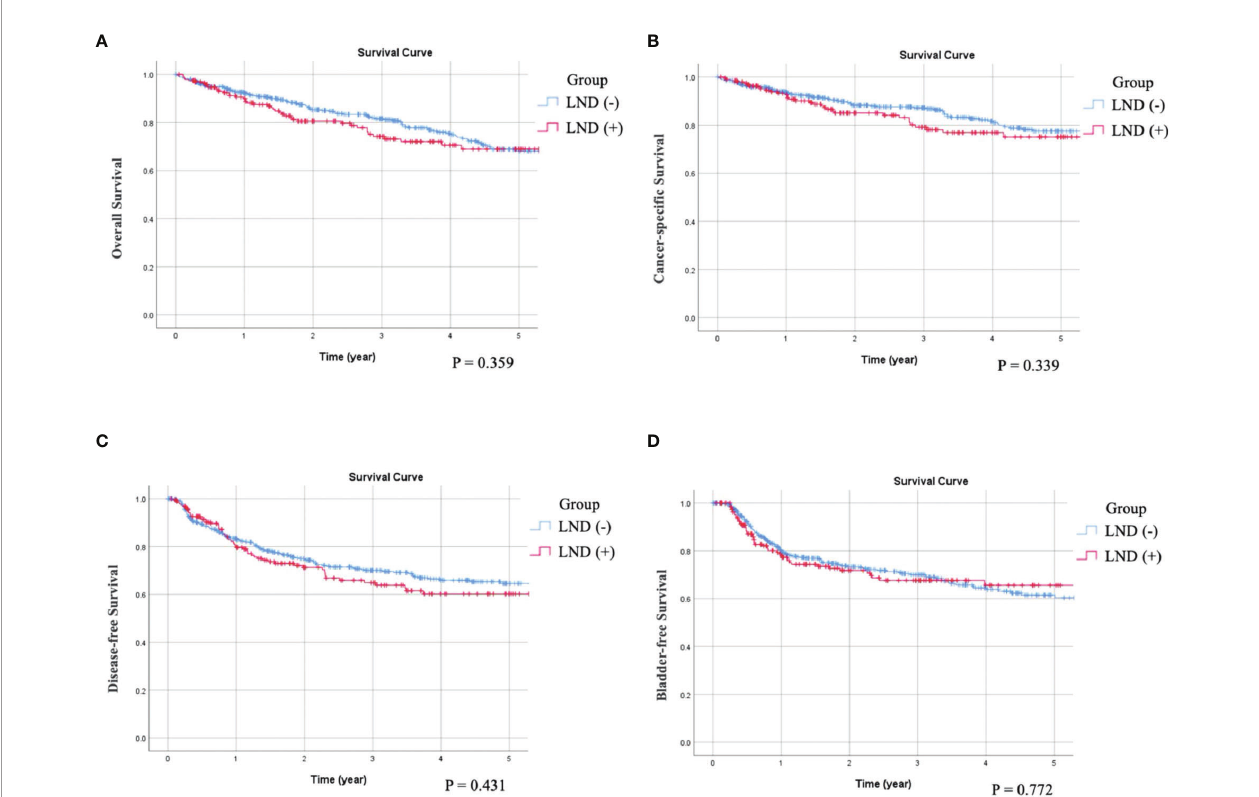
FIGURE 1 | Compare Kaplan-Meier curves between patients without receiving LND (LND (-)) or with receiving LND (LND (+)) by log-rank test. (A) Overall survival, p = 0.359. (B) Cancer-speci fi c survival, p = 0.339. (C) Disease-free Survival, p = 0.431. (D) Bladder recurrence-free survival, p =